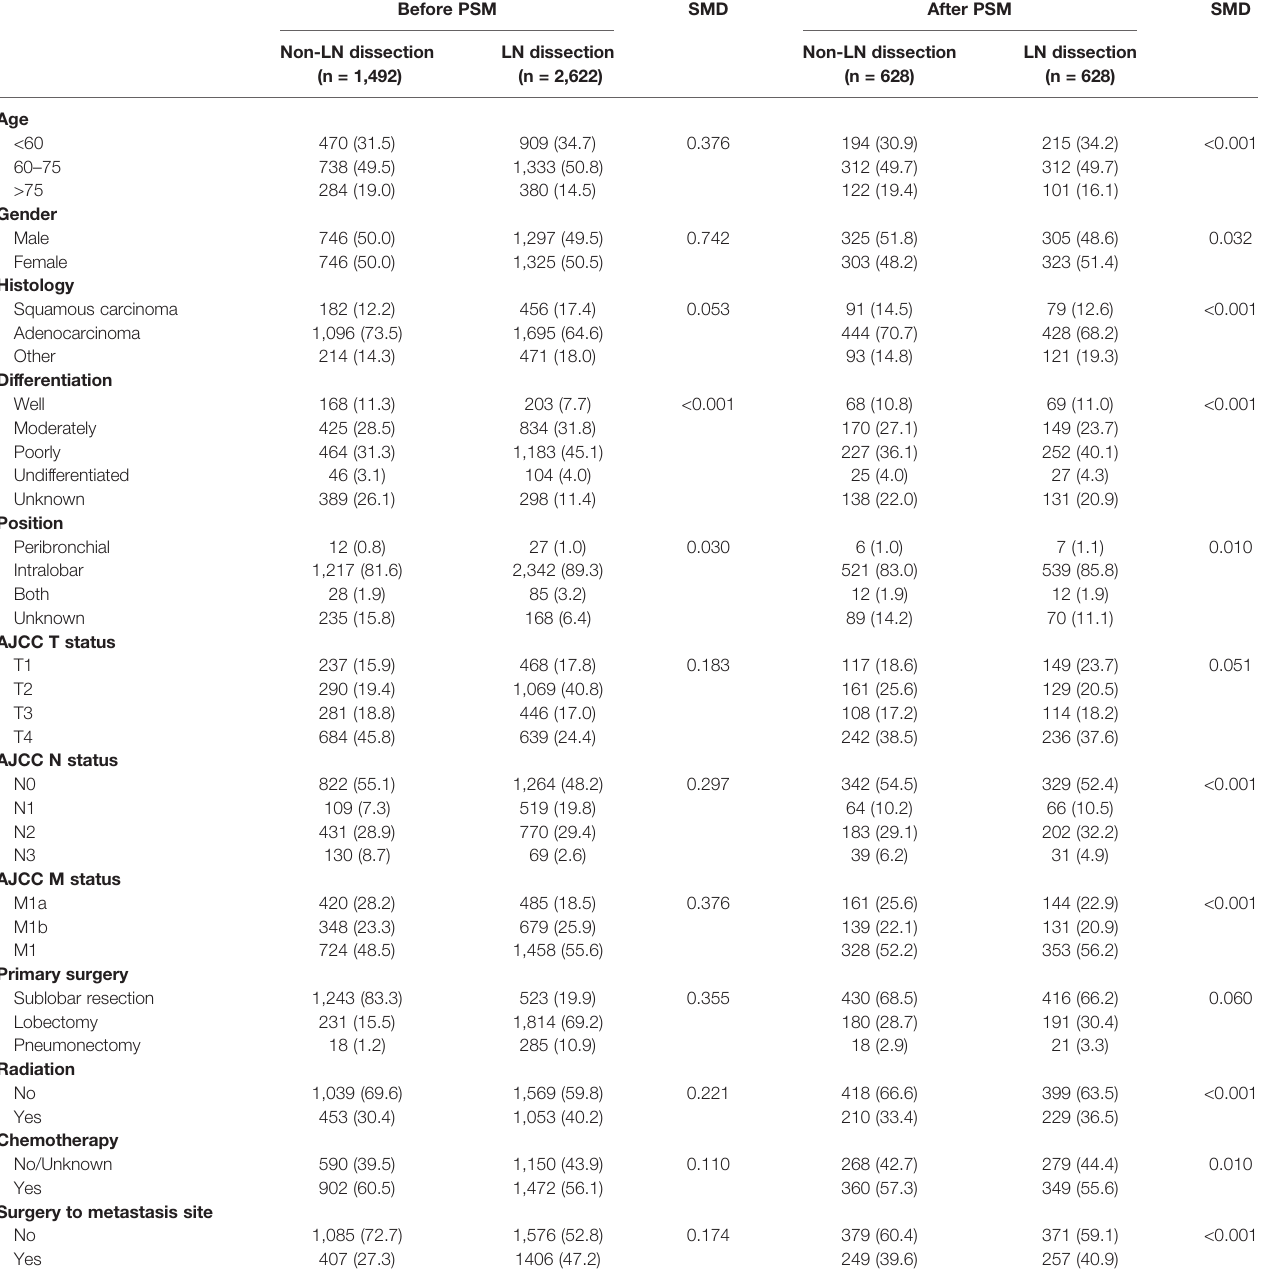
TABLE 1 | Baseline characteristics for patients with Stage IV NSCLC before and after PSM. Before PSM SMD After PSM SMD Non-LN dissection LN dissection Non-LN